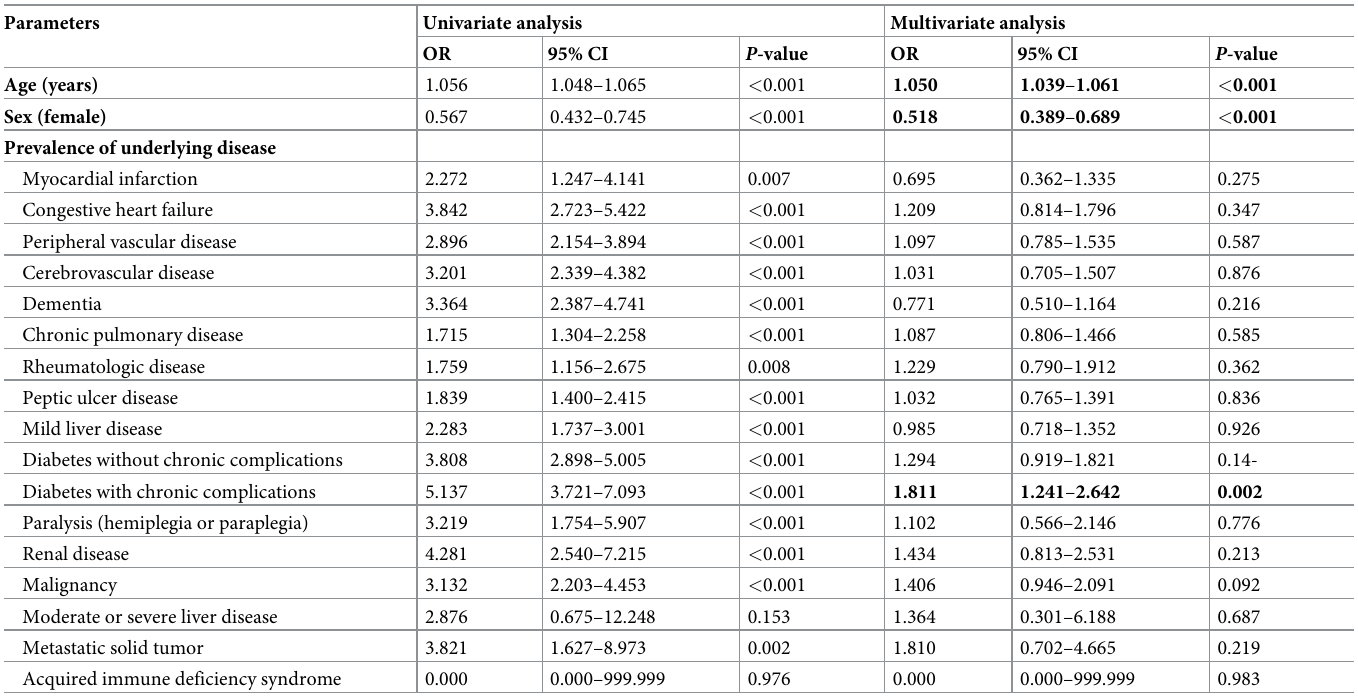
Table 3. Significant factors for ICU